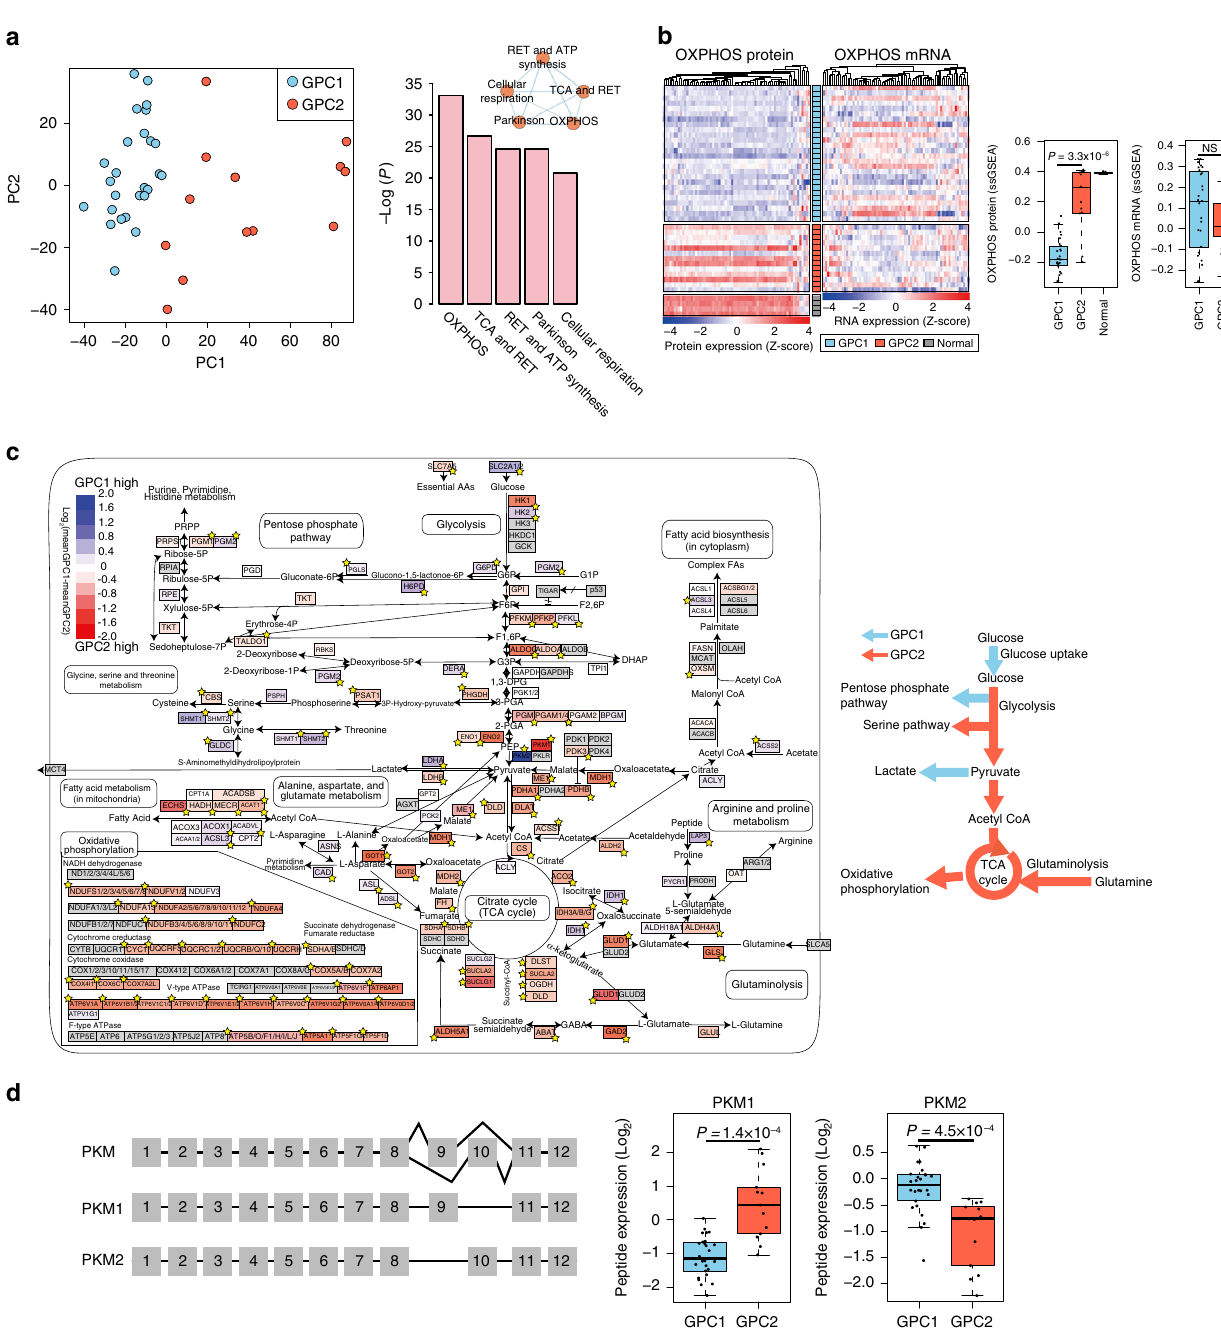
Fig. 3 Proteins involved in central carbon metabolism are major determinants of IDH wild-type GBM proteomic subtypes. a Principal component analysis (PCA) of 39 IDH wild-type GBM samples using global proteome data (left). The statistical signi fi cance of the enriched gene sets with the top 10% loading genes ( N = 390) in PC1 is shown in the right panel. The mutual similarity of the top fi ve gene sets is presented using EnrichmentMap with default parameters. RET respiratory electron transport. b Clustering heatmaps of IDH wild-type GBM tissues with the OXPHOS-related genes based on protein and mRNA expression data (left). The rows represent the tumor samples grouped by proteomic subtype, and the columns represent the genes belonging to the OXPHOS-related gene set. Comparisons of the single-sample gene set enrichment analysis (ssGSEA) scores for both proteins and genes are shown on the right. The box-and-whisker plots represent the medians (middle line), fi rst quartiles (lower bound line), third quartiles (upper bound line), and the ±1.5× interquartile ranges (whisker lines); the raw data are overlaid. P -values were calculated using the two-sided unpaired Wilcoxon rank-sum test. NS not signi fi cant. The number of samples for GPC1, GPC2, and normal is 26, 13, and 4, respectively. c Pathway view of differentially expressed proteins involved in central carbon metabolism between the two proteome subtypes. The stars indicate a statistically signi fi cant difference in protein expression between the two GPC subtypes ( P < 0.05; two-sided unpaired Student ’ s t -test. See Supplementary Data 3 for exact P -values). Genes with no available protein expression data are shown in gray. The elevated pathways in GPC1 and GPC2 tumors are summarized as colored arrows in the right panel. d Alternative splicing of pyruvate kinase muscle isozyme (PKM) isoforms (left) and comparison of the peptide expression of PKM1 and PKM2 in GPC subtypes (right). The y axes of the boxplots represent the peptide expression of PKM isoforms normalized by the GIS. The description of box-and-whisker plots are the same as in b . The P -value was calculated by two-sided unpaired Student ’ s t -test. The number of samples for GPC1 and GPC2 is 26 and 13,